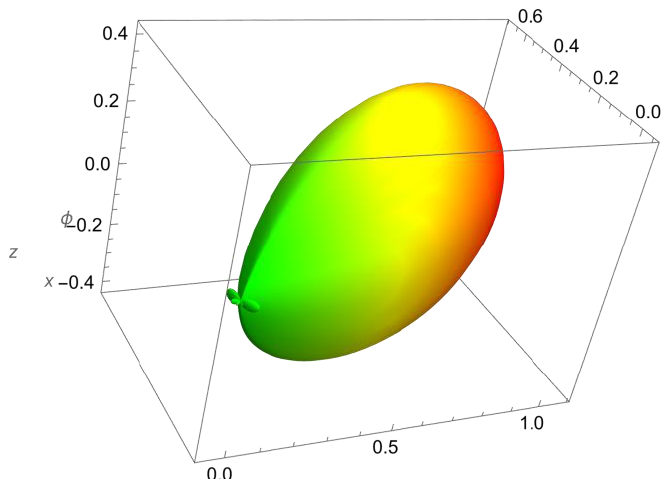
Figure 9. Vertical view of the formed narrow beam.